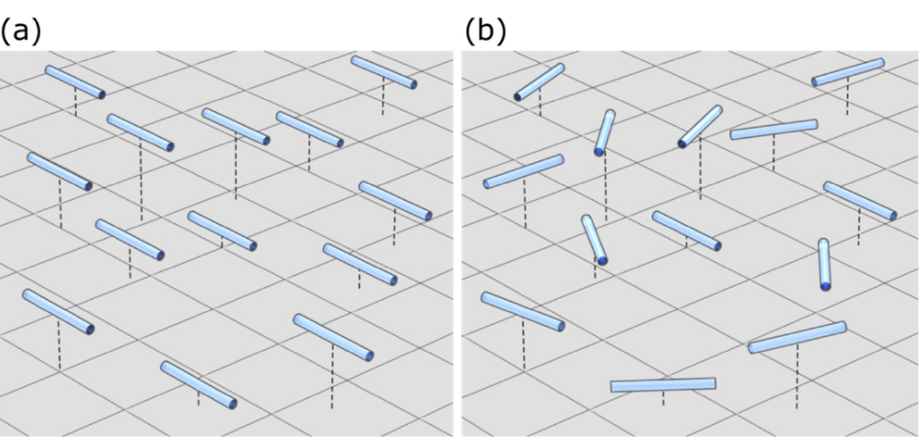
Figure 3. Schematics showing horizontally oriented cylinder models following Liou [92]: ( a ) uniform orientation in the horizontal plane; and ( b ) random orientation in the horizontal plane. Note that particles in ( b ) are rotated about dotted lines from particles in ( a ).